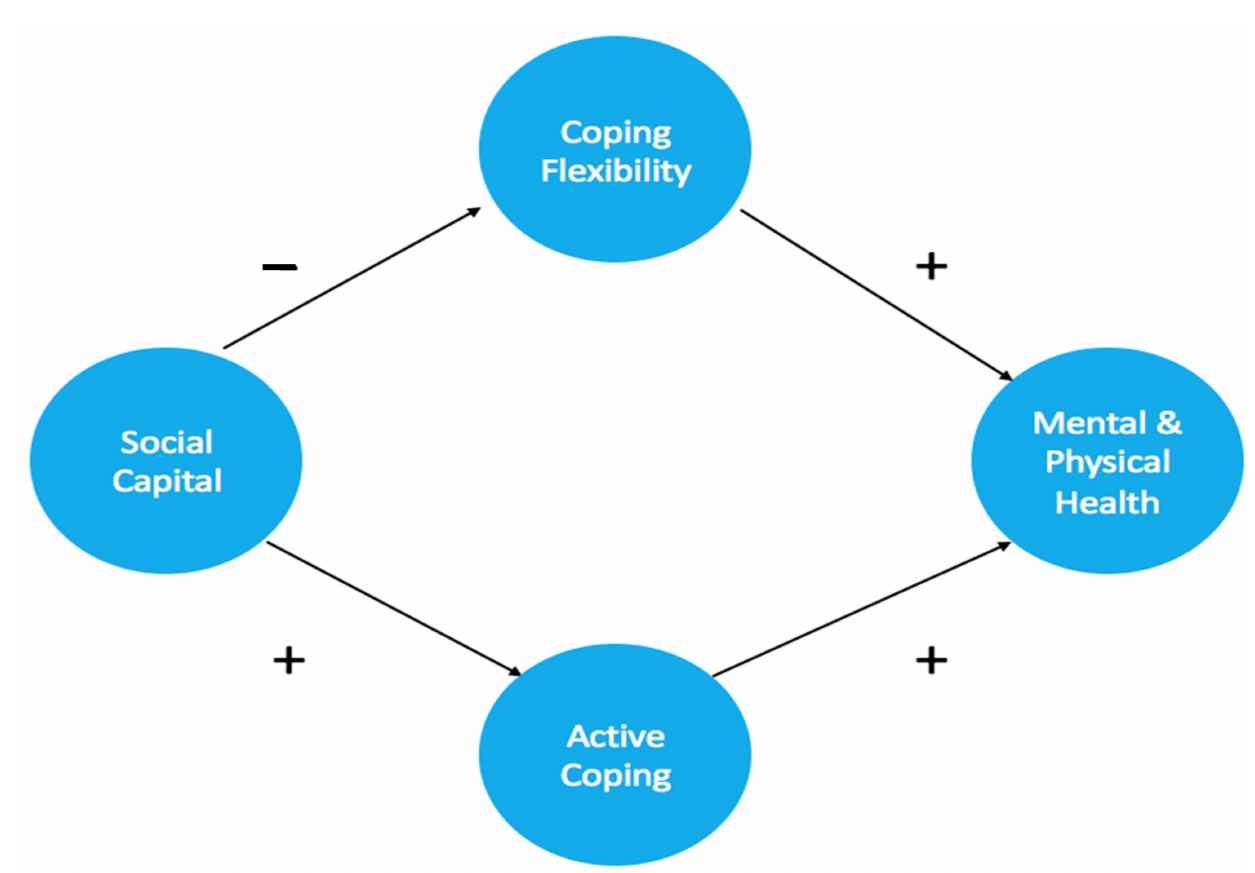
Figure 1. Conceptual framework of the proposed dual process